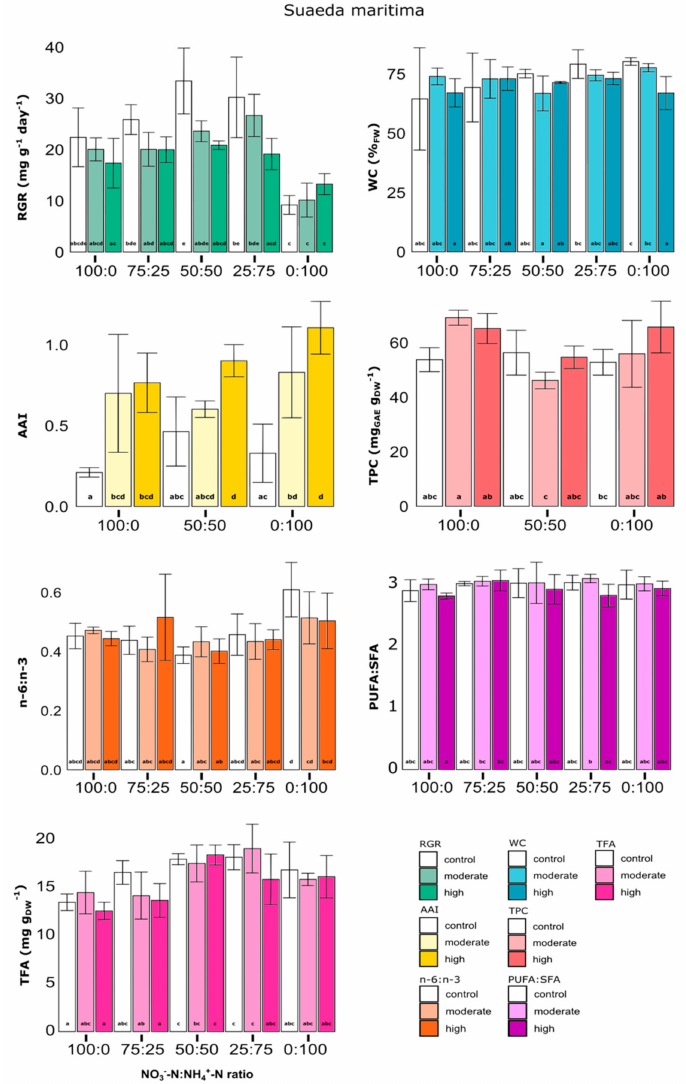
Figure 2. Multiple comparisons of relative growth rate (mg g − 1 day − 1 ), water content (% FW ), antioxidant activity index (AAI), total phenolic compound (TPC) content (mg GAE g DW − 1 ), total fatty acid (TFA) content (mg g DW − 1 ), ratio of polyunsaturated on saturated fatty acids (PUFA:SFA) and ratio of omega 6 on omega 3 fatty acids (n − 6:n − 3) in Suaeda maritima, between combined treatments of salinity and N-ratio in irrigation water. For each variable, values with the same letters are not significantly different between treatments ( p < 0.05). Data are mean ± SD ( n =